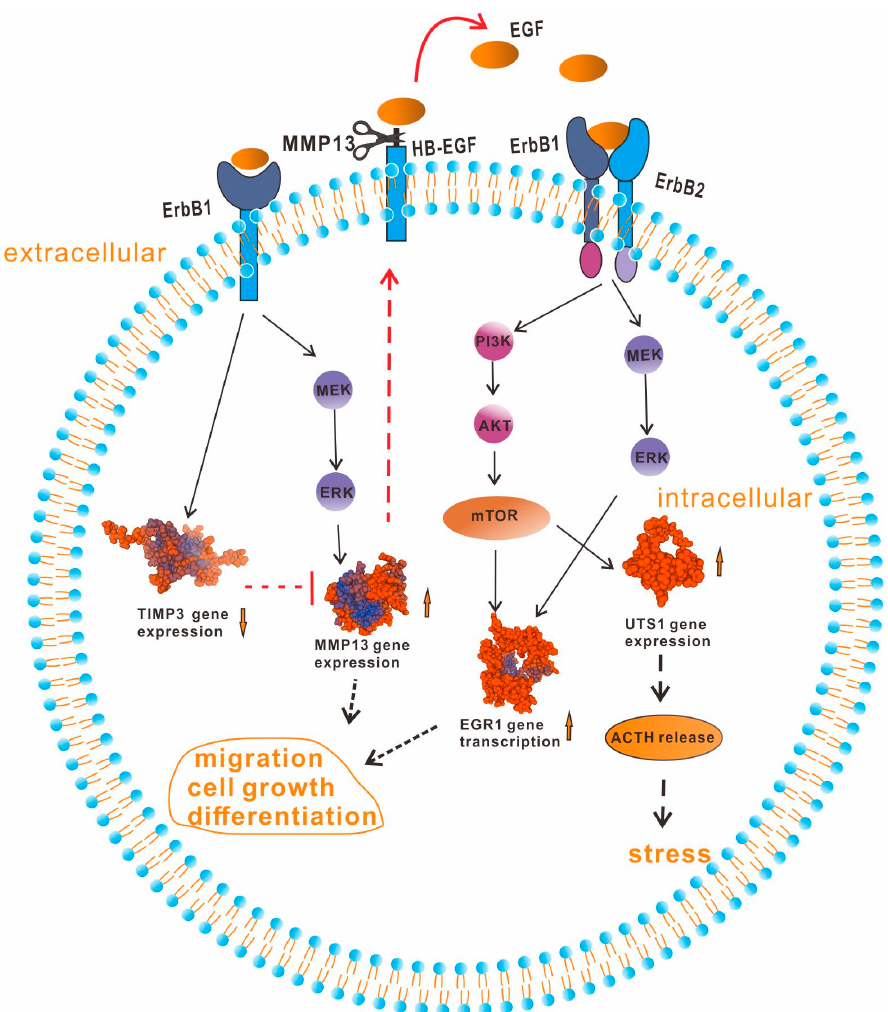
Figure 8. Working modal of EGF-induced UTS1 , EGR1 , MMP13 , and TIMP3 regulation in grass carp pituitary. EGF induced UTS1 and EGR1 mRNA expression were mediated by the PI 3 K/AKT/mTOR and MEK1/2/ERK1/2 pathways coupled with both ErbB1 and ErbB2. EGF-induced MMP13 mRNA expression was only through the MEK1/2/ERK1/2 pathway coupled with ErbB1 and inhibited TIMP3 mRNA expression via ErbB1. EGF-induced MMP13 might be involved in the up-regulation of UTS1 and EGR1 mRNA expression by EGF in grass carp pituitary cells. The solid arrows indicated that the actions were verified by our study, the dotted arrows indicated that the actions were verified basing on the references. And the dotted “T” represented the inhibited action basing on the references.